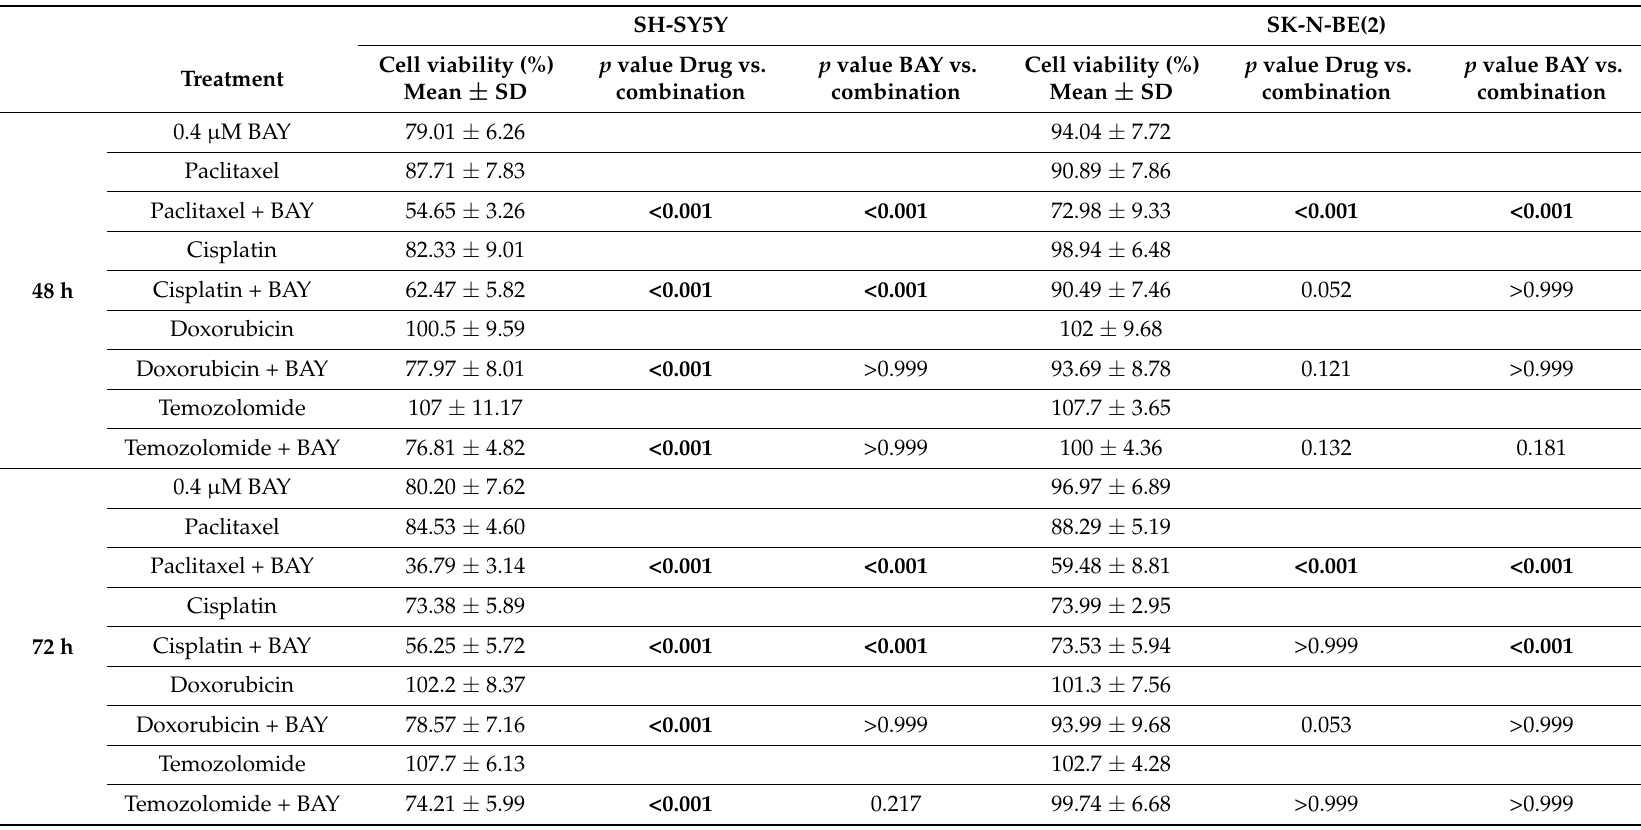
Table 2. Cell viability of SH-SY5Y and SK-N-BE(2) after treatment with 0.4 µ M BAY 61-3606, chemotherapeutic drugs or combinations of both. SH-SY5Y SK-N-BE(2)